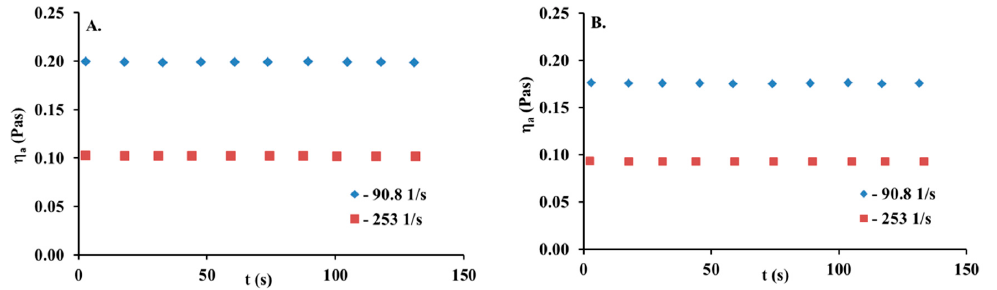
Figure 2. Time-dependent viscosity for 5 mg/mL collagen solution at two different and constant shear rates, ( A ) 16.5 °C, ( B ) 25.2 °C.